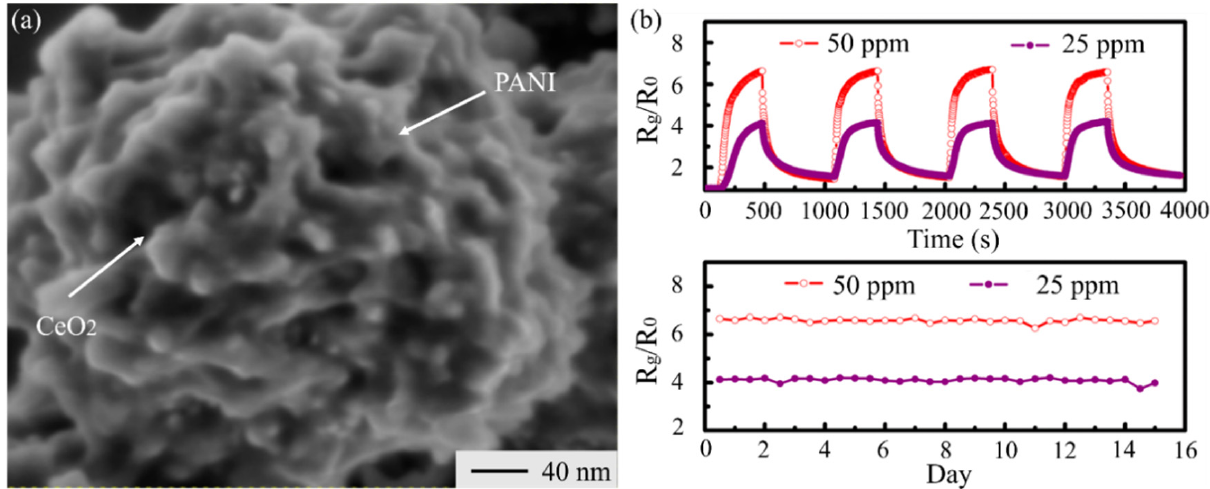
Figure 10. PANI-CeO 2 gas sensor polymers. Adapted from [135] copyright (2014), with permission from American Chemical Society. [135]. ( a ) The morphology of PANI-CeO 2 nanoparticles; ( b ) the response of PANI-CeO 2 nanoparticles to NH 3 .